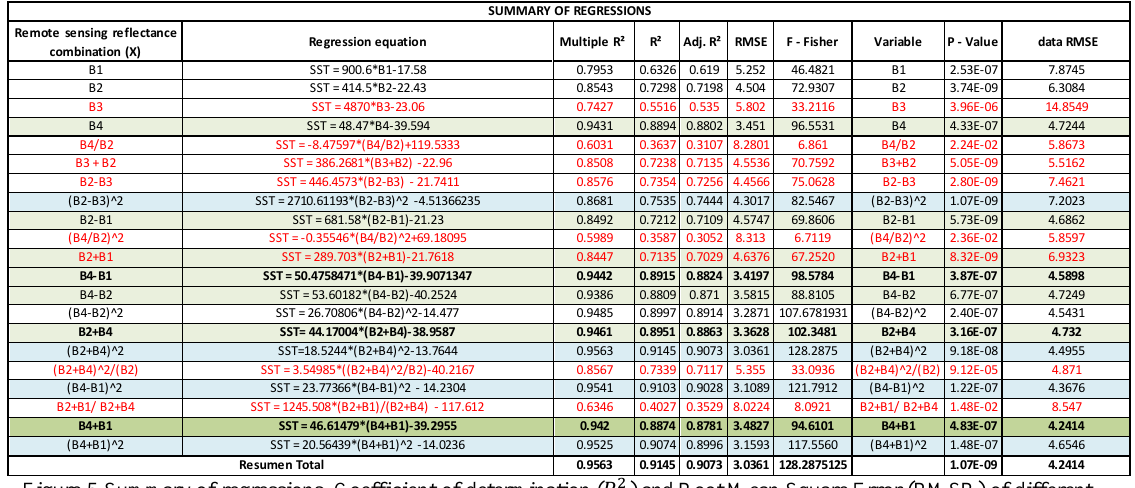
Figure 5 Summary of regressions. Coefficient of determination ( 𝑅 2 ) and Root Mean Square Error (RMSR) of different regressions for combinations of the wavelength bands. Colour red for low goodness of fit regressions, blue for quadratic regressions with high goodness of fit and green for linear regressions with high goodness of fit. Having obliquity in the photograph was not possible to observe an orthophoto that would allow entire length of the river studied, therefore there is shown two photographs separately. A reclassification in 30 categories was performed in order to observe carefully changes in concentrations of TSS. The distribution found is consistent with the expected results, finding that the chosen regression is a good fit and can effectively relate TSS concentrations with Reflectance values obtained from aerial